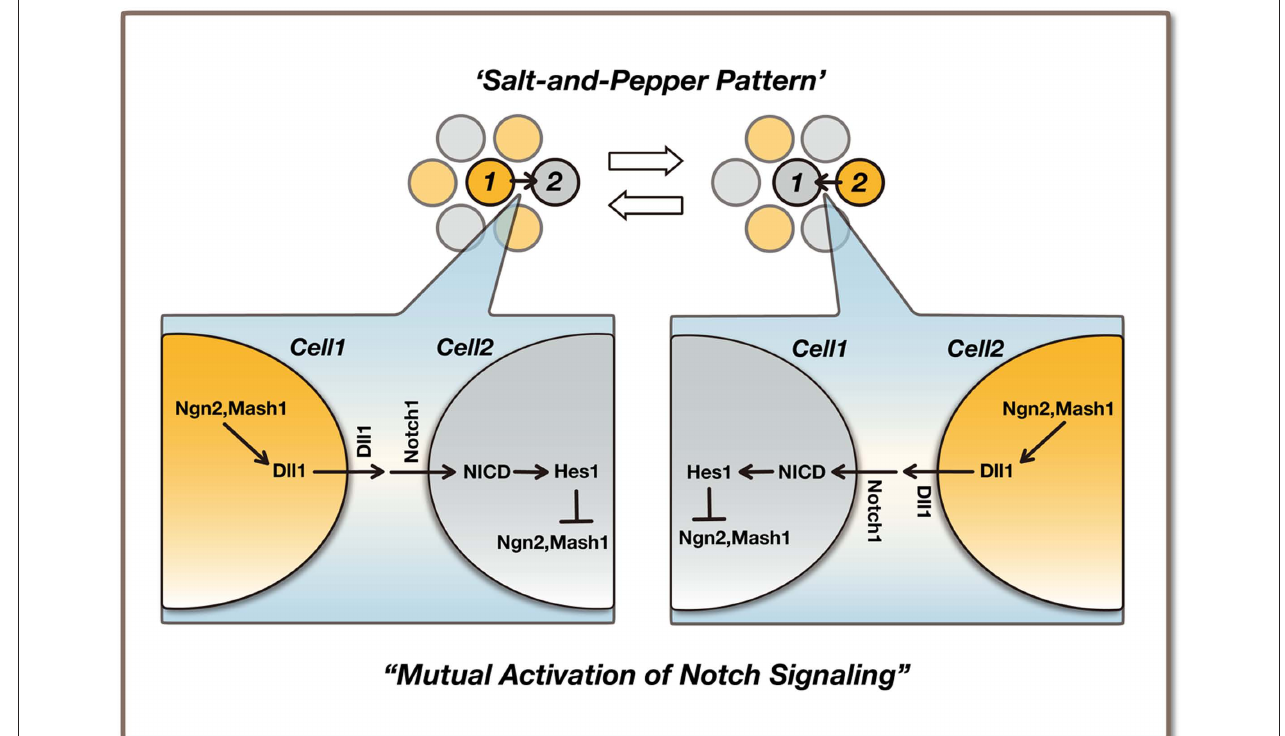
Figure 5 | Maintenance of neural stem/progenitor cells by the mutual activation of Notch signaling. Ngn2 and Dll1 oscillations are regulated by Hes1 oscillation in neural stem/progenitor cells. Ngn2 oscillation may be advantageous for the maintenance/proliferation of neural stem/progenitor cells during the early stages